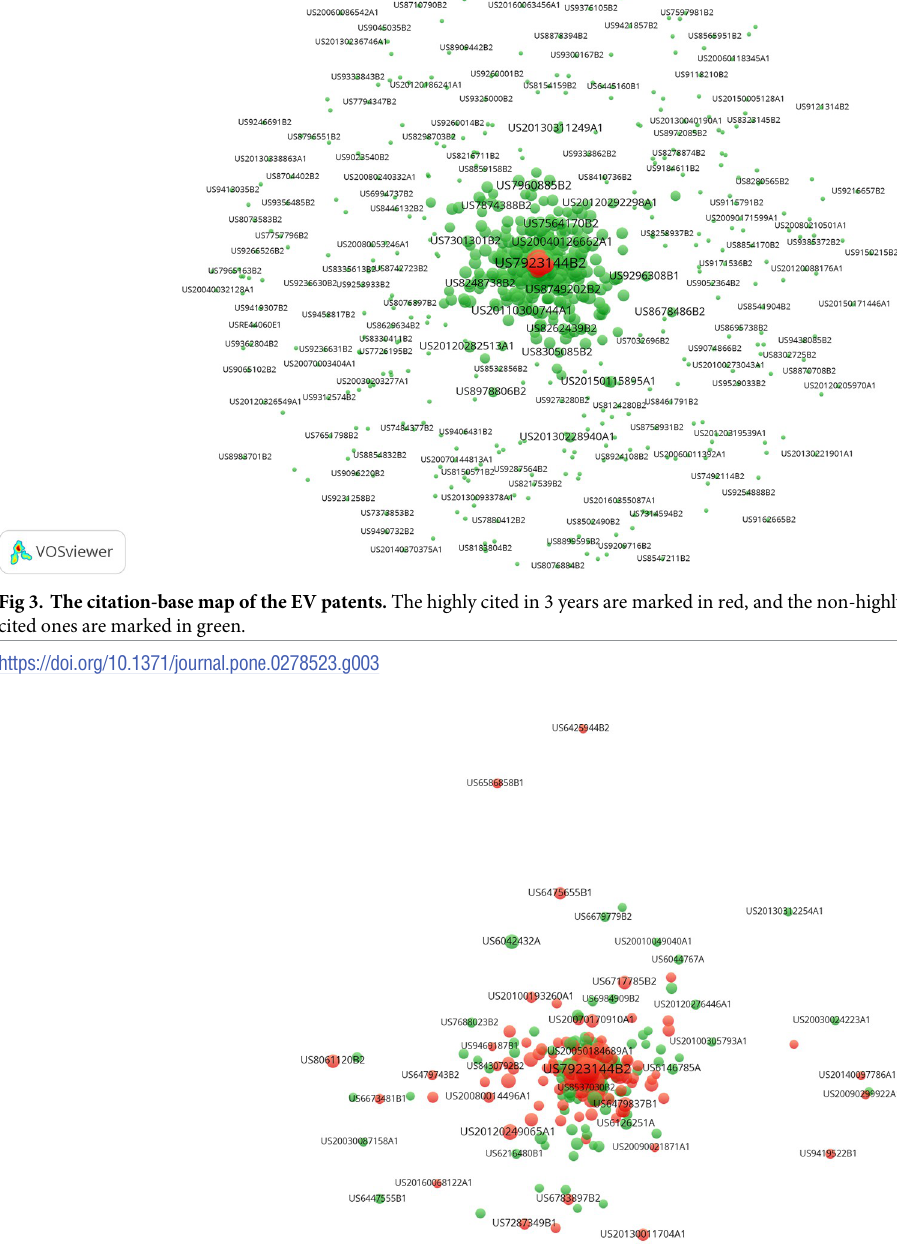
PLOS ONE | https://doi.org/10.1371/journal.pone.0278523 December6,